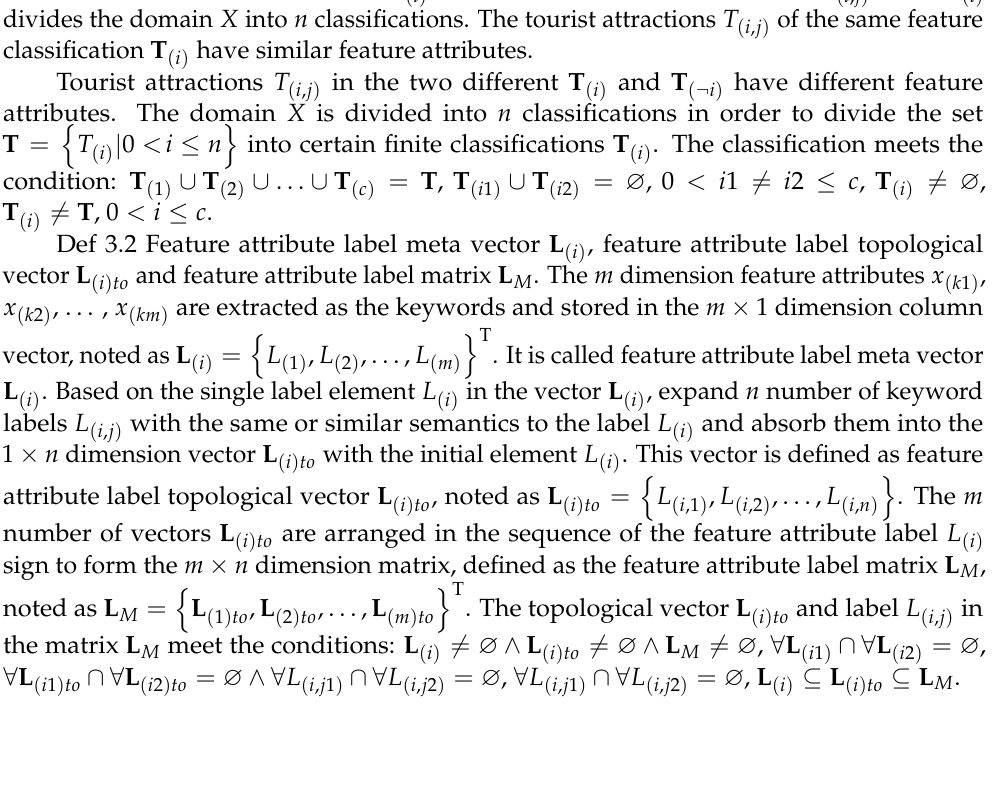
Figure 3. An example for Algorithm 2. ( a ) is the sample distribution, ( b ) shows the d samples, and the ( c ) shows the clustering sample.